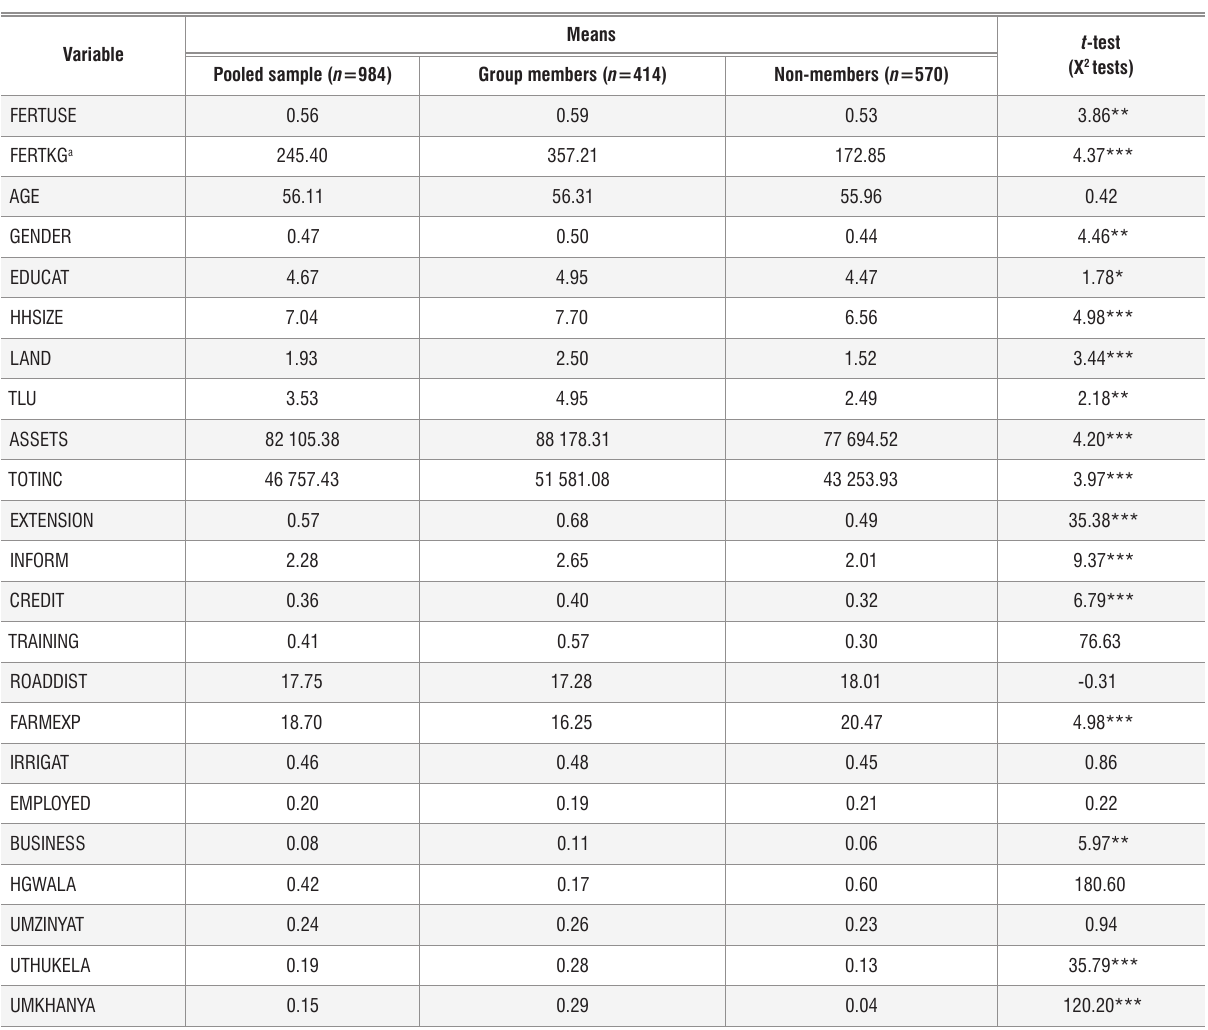
Descriptive statistics of sample households according to group membership status